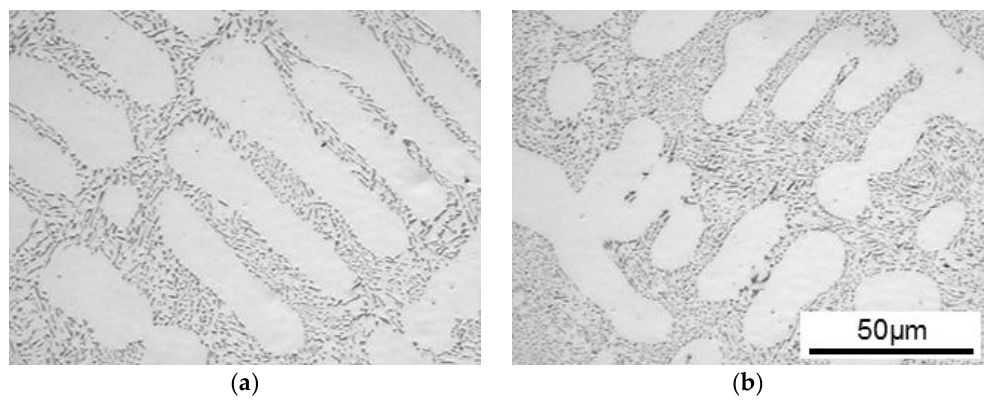
Figure 1. Optical micrographs; ( a ) Al-9.8%Si-3ppmP cast alloy and ( b ) Al-10.1%Si-4ppmP-108ppmSr cast alloy.